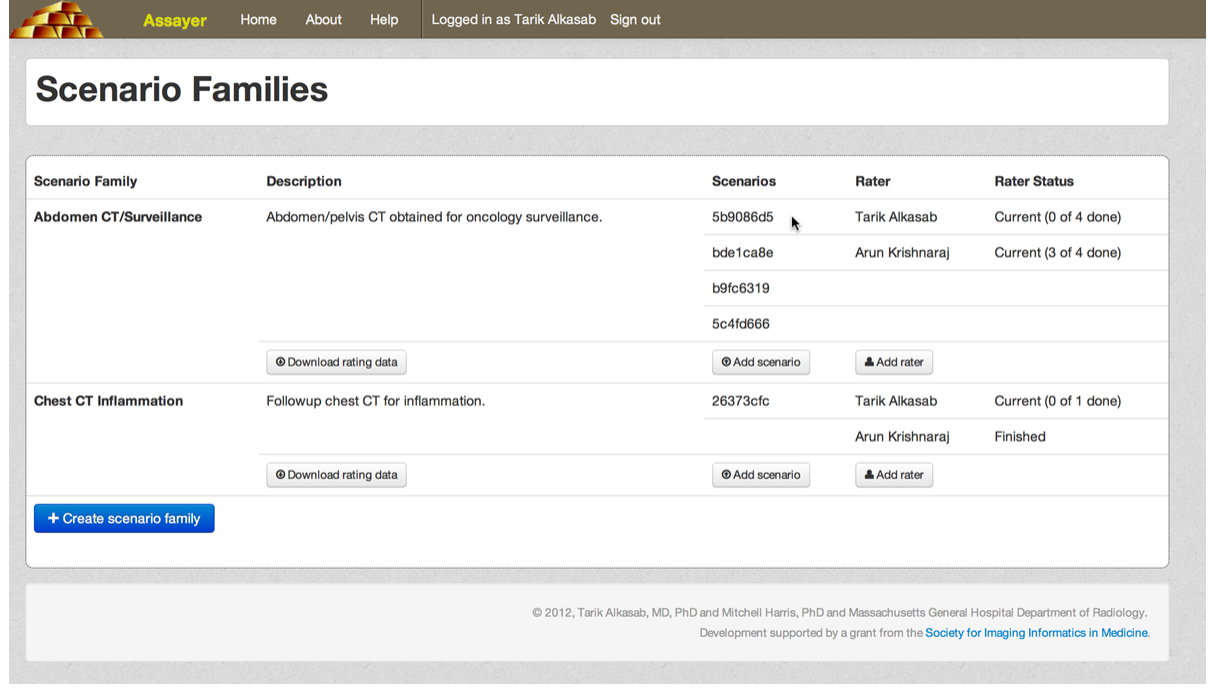
Figure 4. Administrator monitoring interface. An administrator keeping track of activity on the service can view the monitoring page, which shows all of the active scenario families, the scenarios making them up, the raters assigned to evaluate the items, and their progress in rating all of the items. Tools for defining new scenario families, uploading scenarios, and adding raters are also available from this